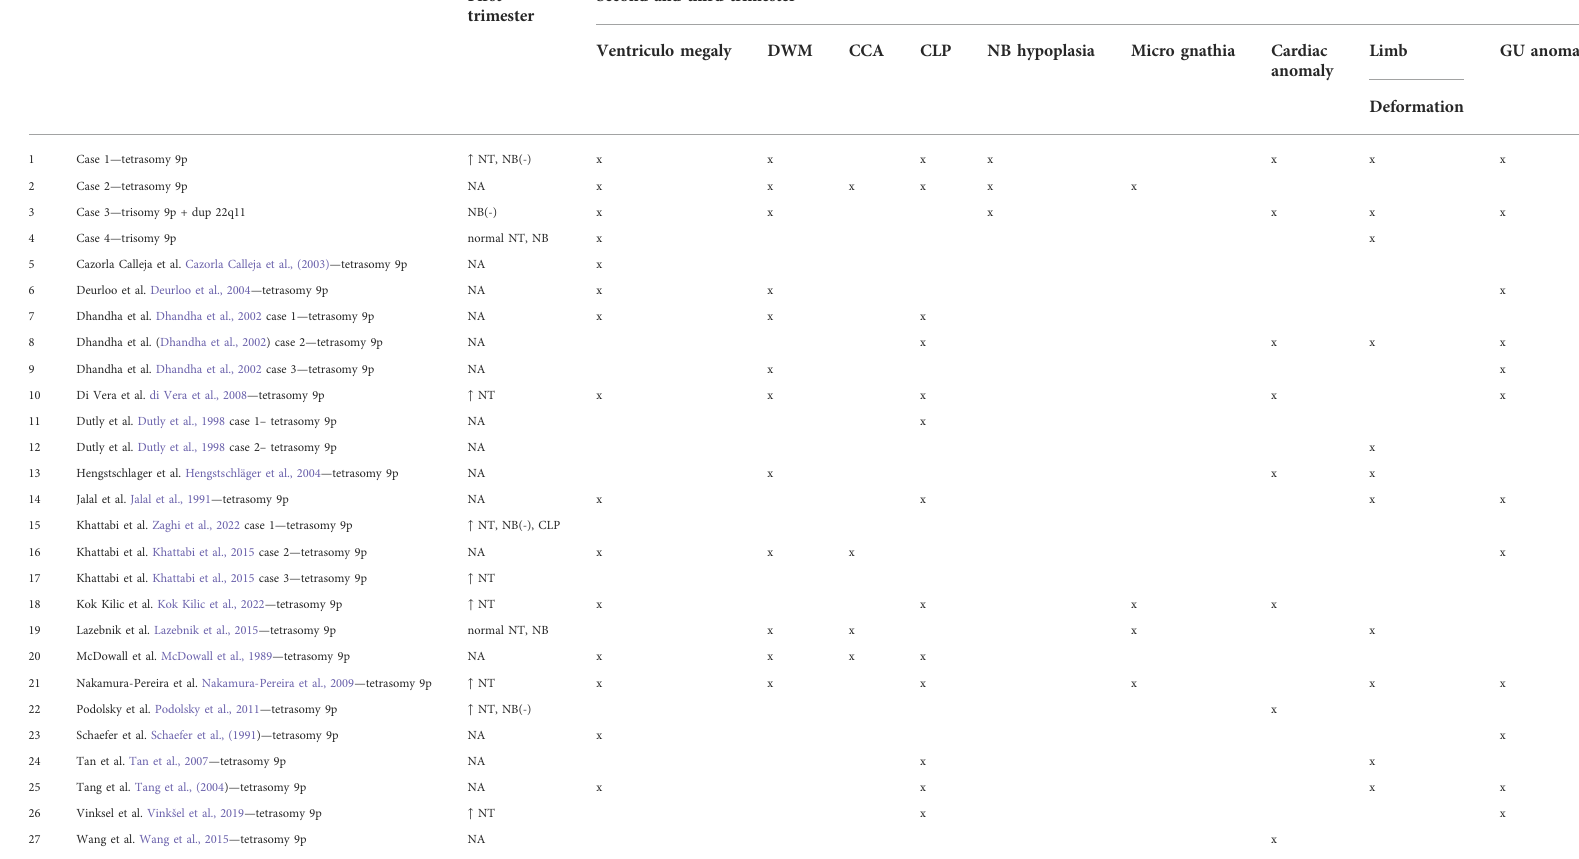
TABLE 1 Prenatal sonographic features of four described cases and cases from the literature.